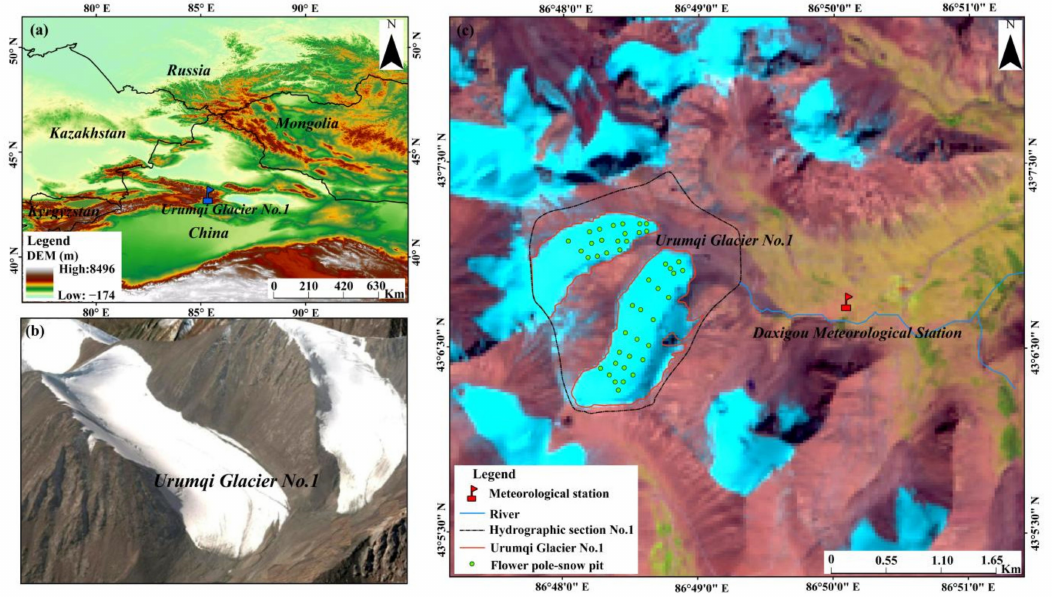
Figure 1. ( a ) Location map of Urumqi Glacier No.1 (UG1). ( b ) Image of UG1. ( c ) Location of Daxigou Meteorological